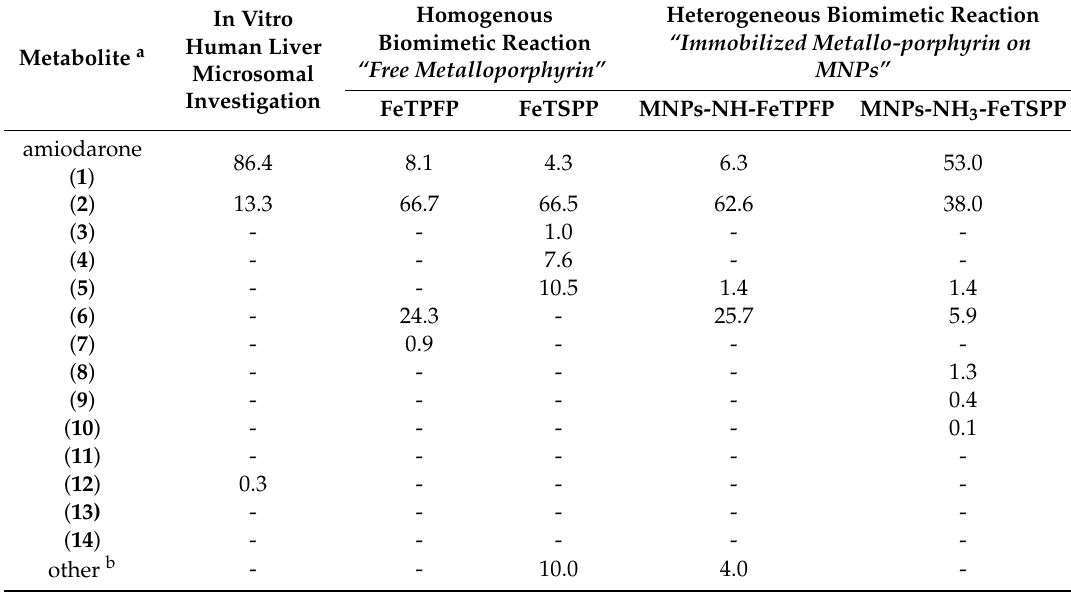
Table 2. Metabolite profile of amiodarone from homogenous (free metalloporphyrin catalyzed: FeTPFP or FeTSPP) and heterogeneous (immobilized metalloporphyrin on MNPs: MNPs-NH-FeTPFP or MNPs-NH 3 -TSPP) biomimetic oxidations in batch